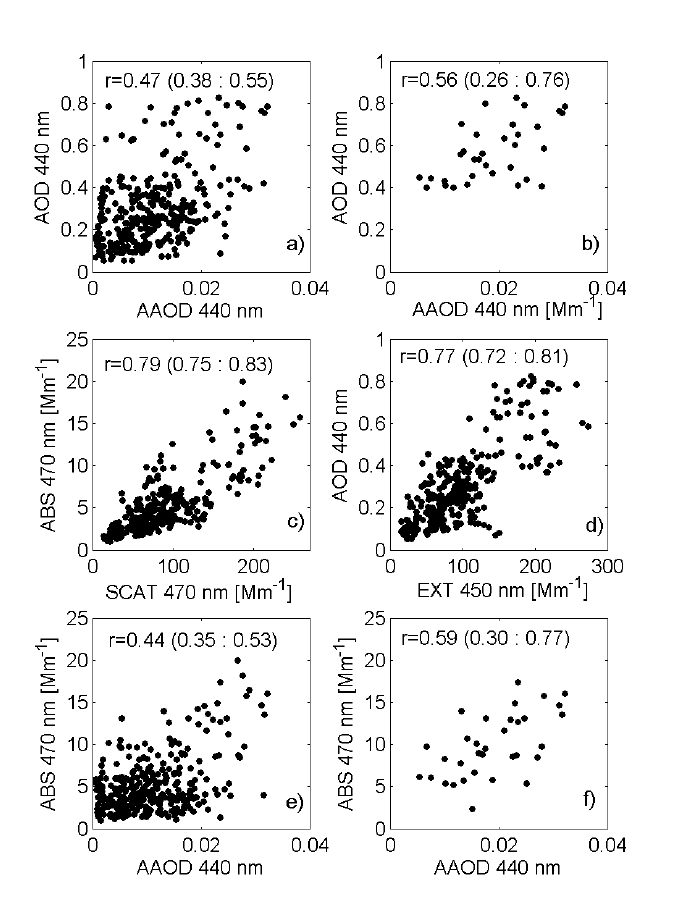
Figure 8. Comparison of ( a ) Aerosol Robotic Network (AERONET) Level 1.5 (317 cases) and ( b ) 2.0 (33 cases) AAOD and AOD, ( c ) surface absorption (aethalometer) and scattering (nephelometer) coefficient, ( d ) surface extinction (aethalometer + nephelometer) and columnar AOD, ( e ) AERONET level 1.5 and ( f ) 2.0 AAOD with surface absorption (aethalometer) coefficient measured between June and August 2015 at SolarAOT